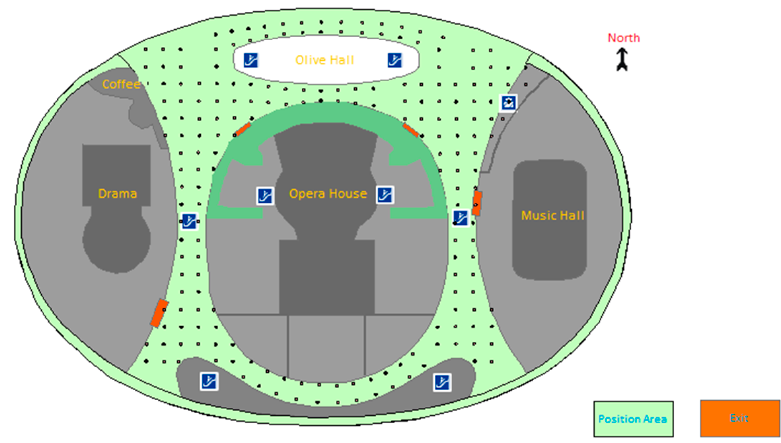
Figure 4. Experimental environments for Test-bed 1. Sensors 2016 , 16 , 2055